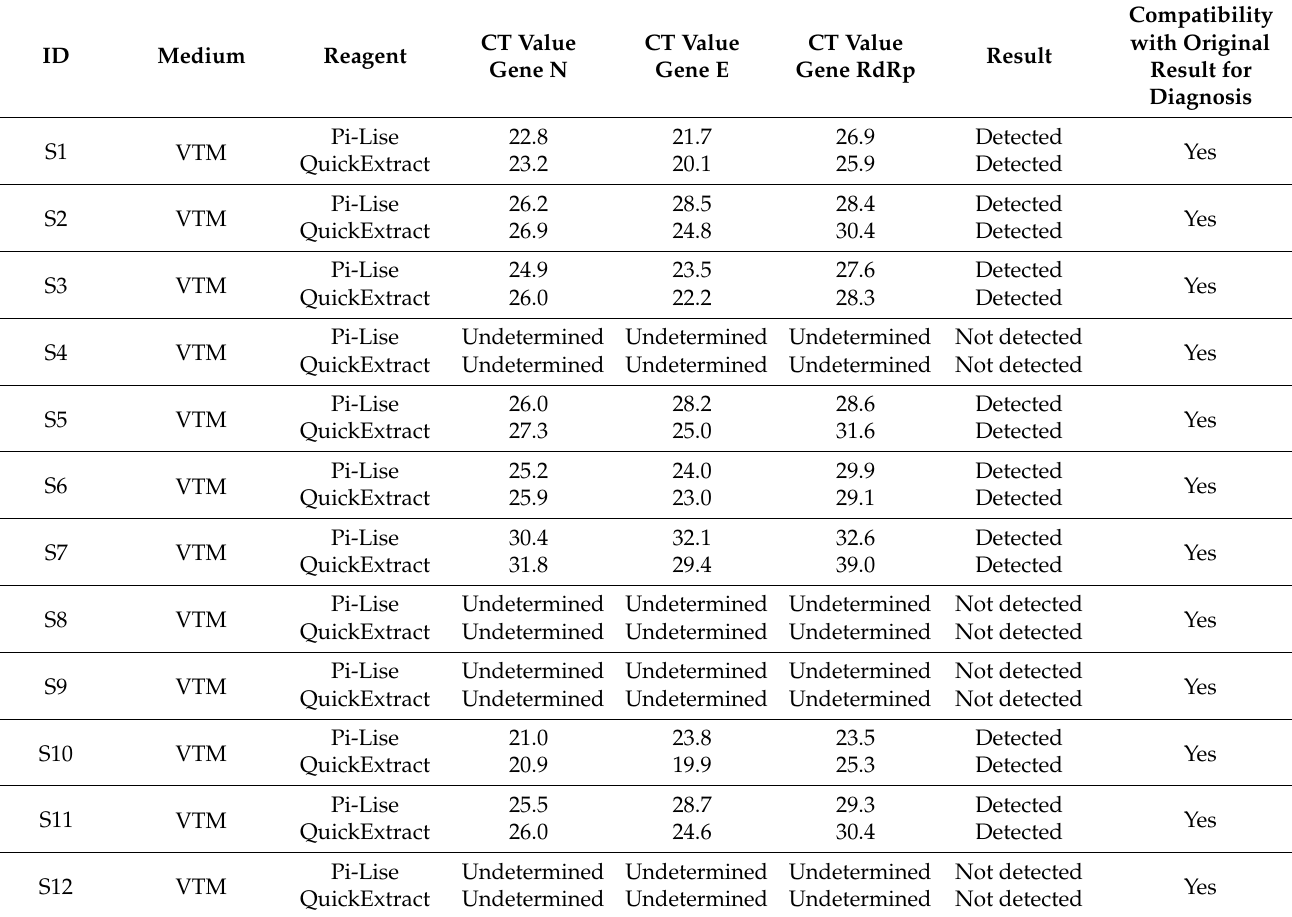
Table 1. RT-qPCR results of reactions performed with Allplex kit after extraction with different reagents (Pi-Lise or